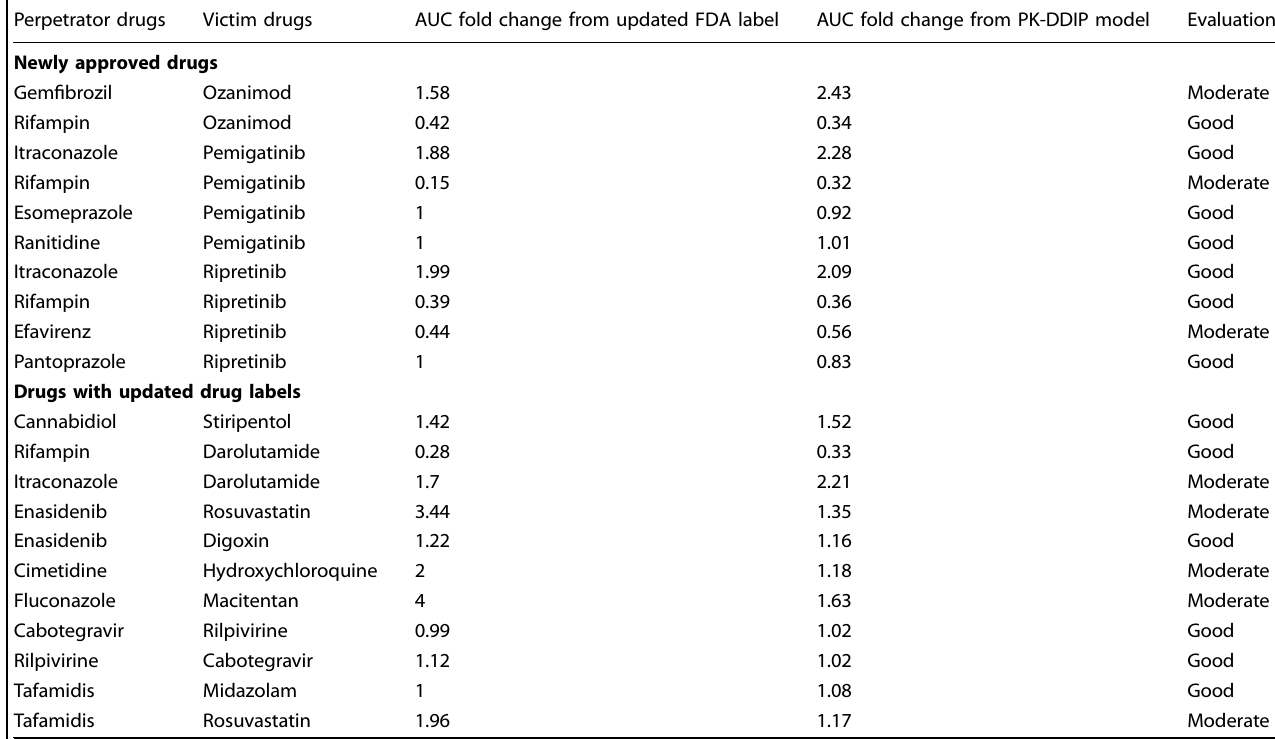
Table 1. Comparison of newly updated drug interaction information with area under the time-concentration curve (AUC) fold changes in the label and predicted AUC fold changes by the pharmacokinetic drug-drug interaction prediction (PK-DDIP) model. Perpetrator drugs Victim drugs AUC fold change from updated FDA label AUC fold change from PK-DDIP model